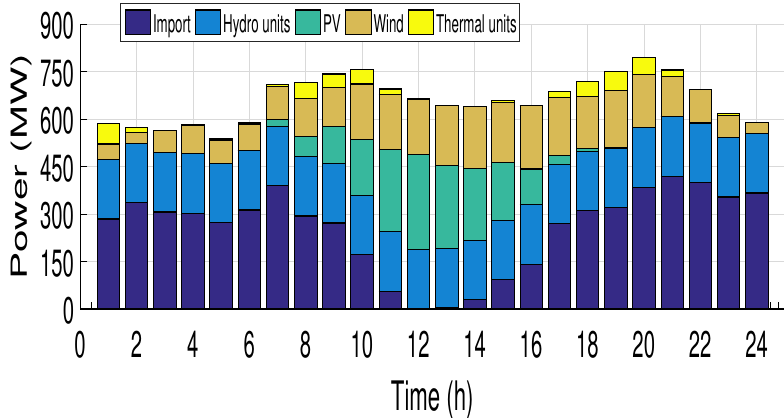
Figure 12. Scheduled power in case 1.